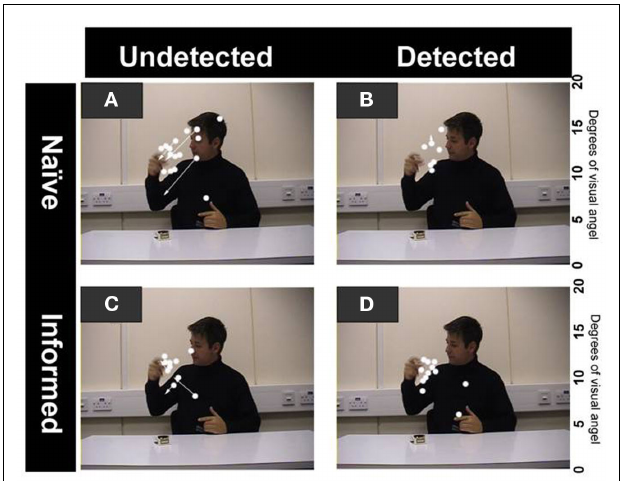
FIGURE 3 | Misdirection works independently of direction of gaze. An eye-tracker was used to record the subjects’ fixation points at the time of the cigaret drop during the magic trick presented in Figure 2 . (A) Results from naïve participants who missed the cigaret drop. (B) Naïve participants who detected the cigaret drop. (C) Informed participants who missed the cigaret drop. (D) Informed participants who detected the cigaret drop. Most of the naïve participants fixated either on the lighter hand, the head, or the area between the lighter hand and the head. Most of the informed participants looked at the lighter hand or the area between the lighter hand and the head. Interestingly, only one informed participant was able to detect the cigaret drop by using his foveal vision, showing that no systematic differences were found between the two conditions. Adapted from Kuhn et al.